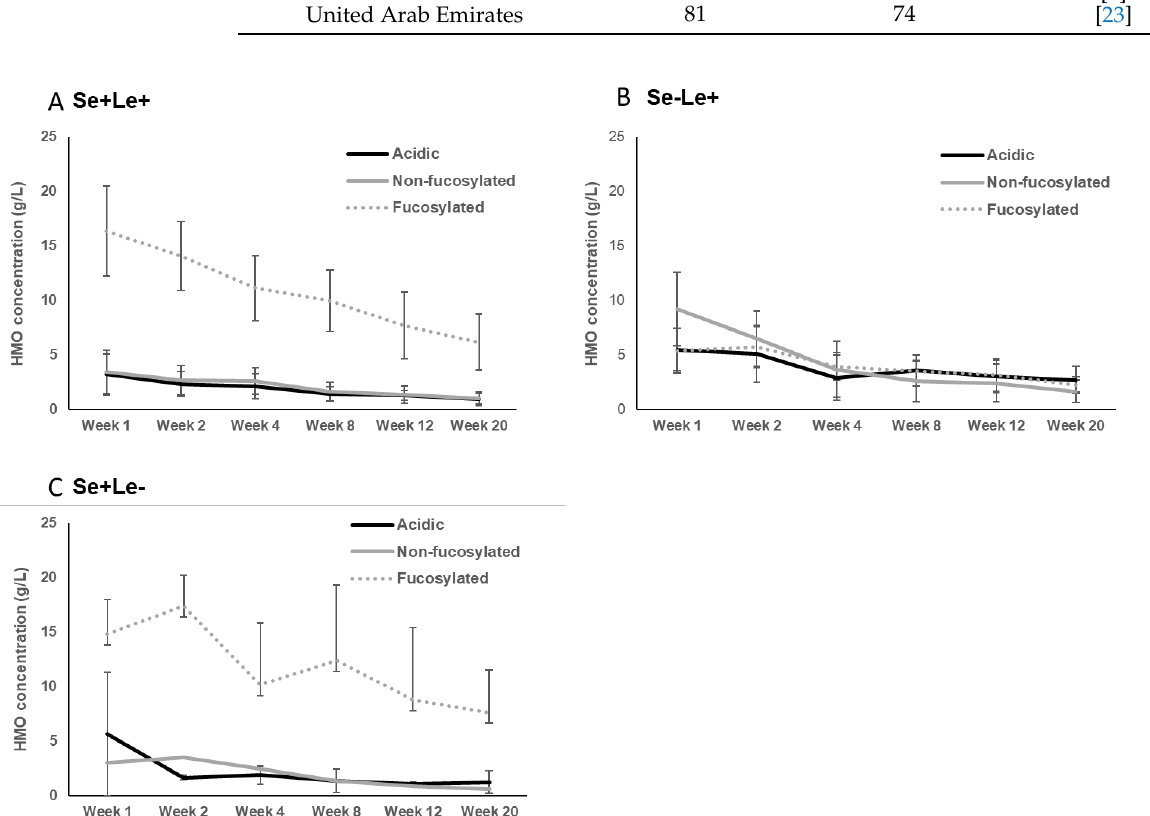
Figure 3. Concentrations of oligosaccharides in Chinese human milk over a 20-wk lactation period for ( A ) Se+Le+ milk-type group n = 22, ( B ) Se−Le+ milk-type group n = 6, and ( C ) Se+Le− milk-type group n = 2. (Adapted from Elwakiel et al., 2018 [1]).